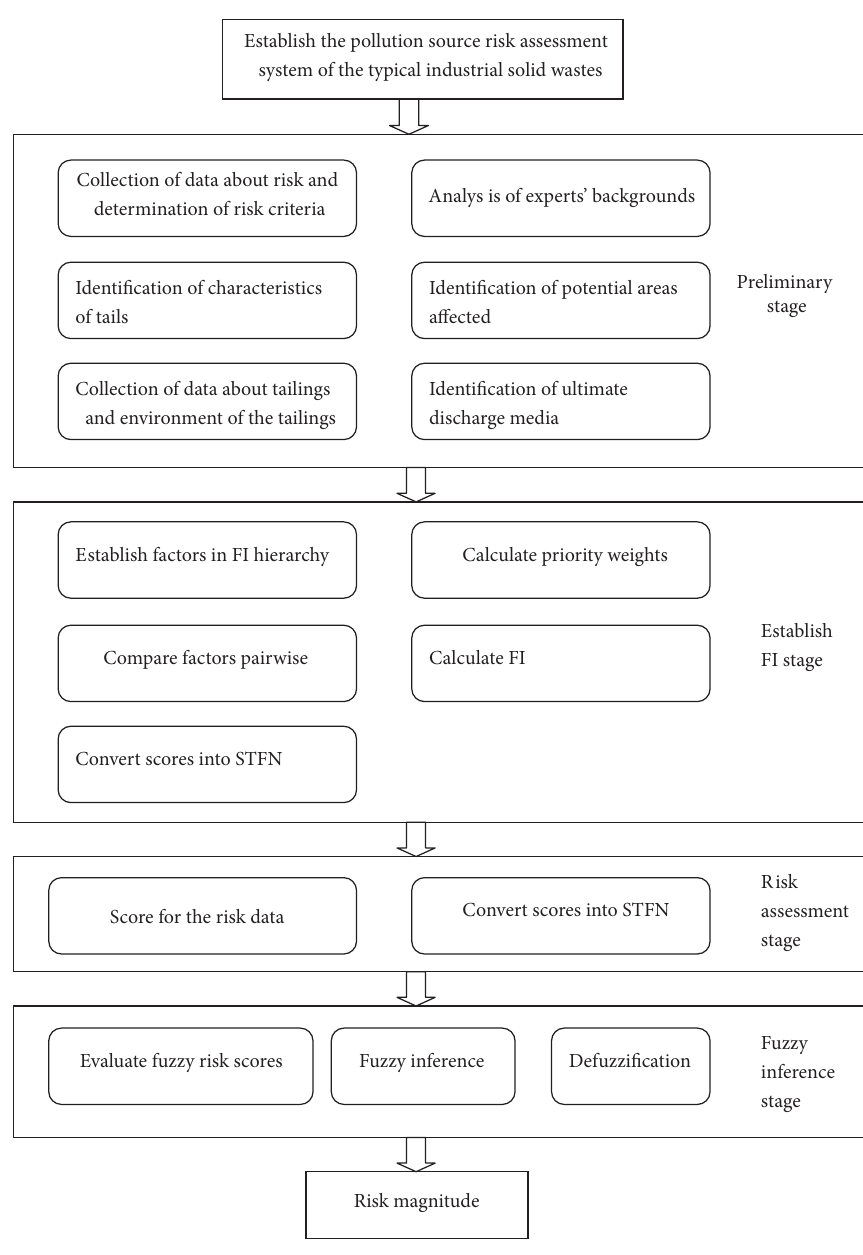
Figure 1: Risk assessment approach of the typical staple industrial solid waste (TSISW).